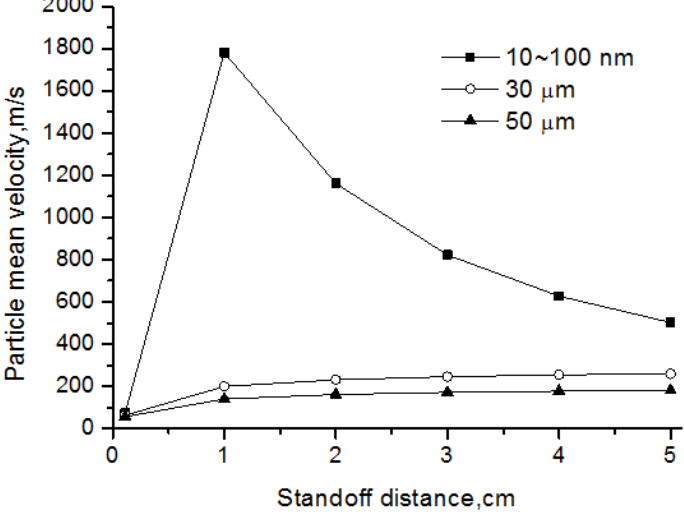
Figure 11. Velocity of nanoparticles and agglomerates.